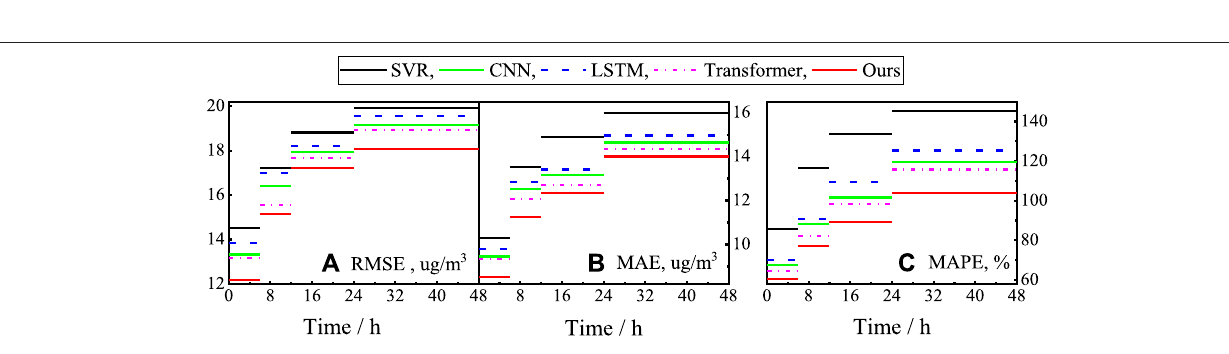
Frontiers in Environmental Science |